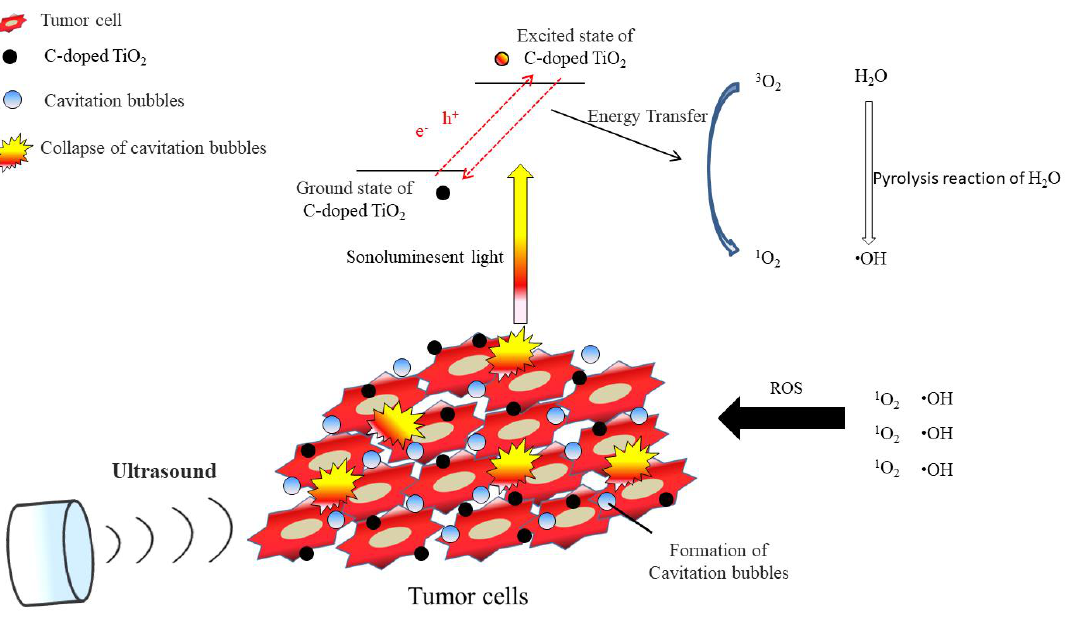
Figure 10. The possible pathway of 4T1 tumor cell damage induced by SDT.